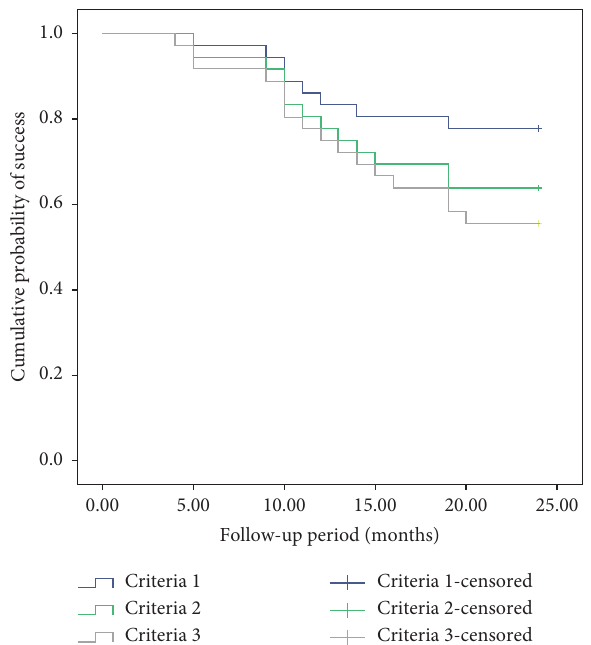
Figure 2: Kaplan–Meier survival analysis. The graph shows the success rates of primary glaucoma device implantation surgery according to criteria 1 (IOP ≤ 18mmHg and an IOP reduction of 20% with 1 or no medication), 2 (IOP ≤ 15mmHg and an IOP reduction of 25% with 1 or no medication) and 3 (IOP ≤ 12mmHg and an IOP reduction of 30% with 1 or no medication) in XFG.